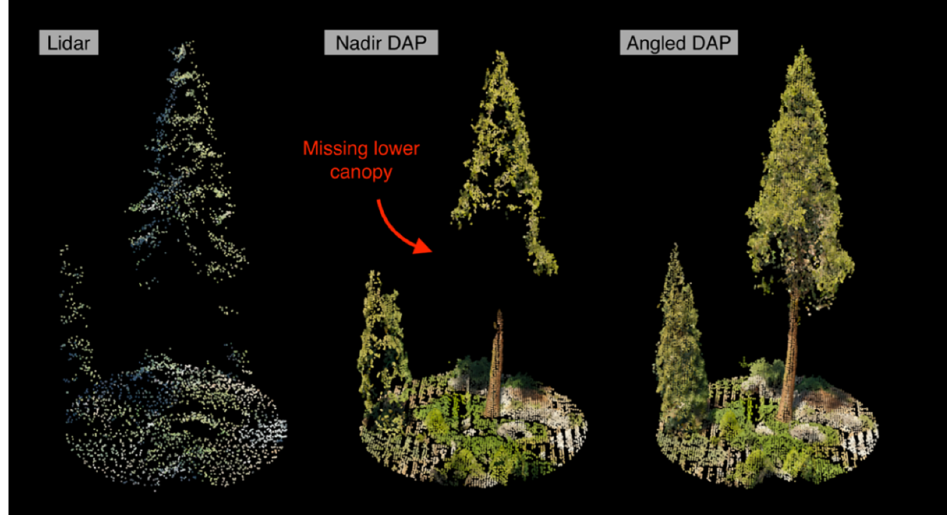
Figure 1. Comparison of lidar, nadir DAP and off-nadir DAP 3D point clouds for a 0.05 ha circular plot in a Sierra Nevada mixed-conifer forest. Red arrow denotes missing structural elements in the lower canopy of the nadir DAP.